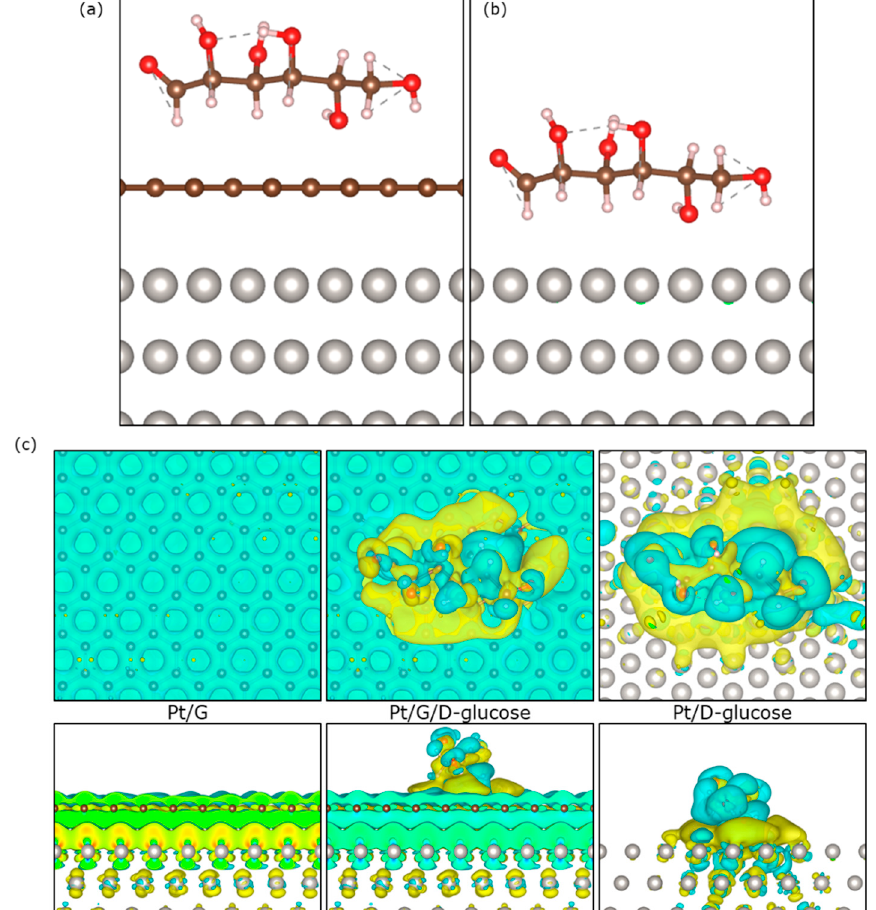
Figure 7. Systems setup. The left panel ( a ) depicts the adsorbed D-glucose on top of a relaxed graphene sheet on top of a Pt <111> substrate. The right panel ( b ) shows the relaxed D-glucose directly on top of the Pt111 substrate. The atoms are shown as spheres, where Pt atoms are rendered in grey, carbons in brown, oxygens in red and hydrogens in white; ( c ) Charge density difference contour plots (generated via VESTA package [VESTA]) for D-glucose on top of Pt <111> substrate and Pt <111>/G combined system. The top subfigures are top views for the contours, while the bottom subfigures show the side views. The atoms are shown as spheres.